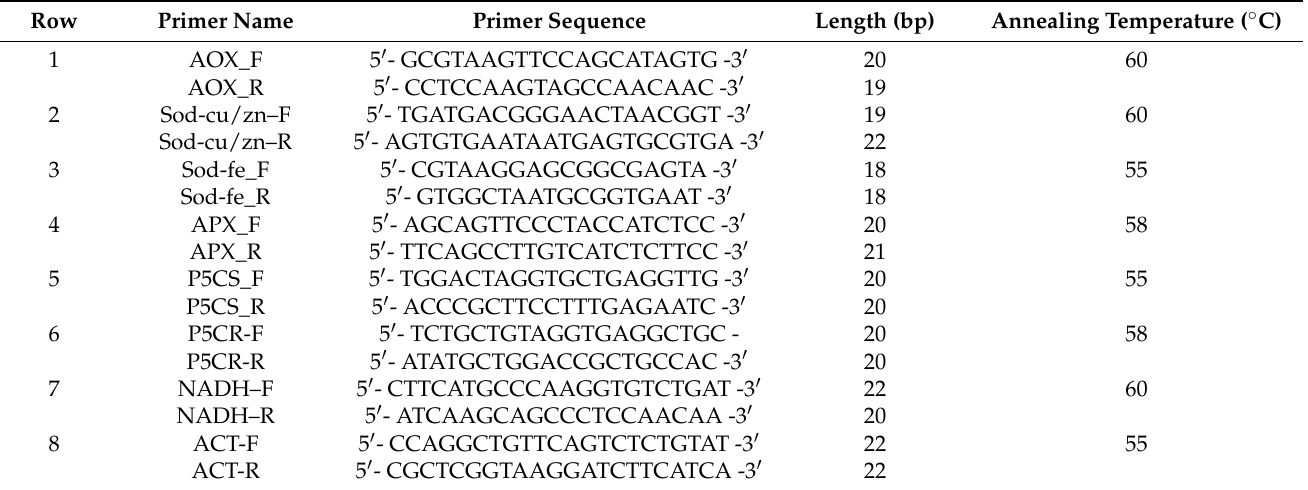
Table 1. Primer sequences used for Real Time PCR analysis in “Mexican lime” ( Citrus aurantifolia ( Christm ) Swingle) and “Persian lime” ( Citrus latifolia